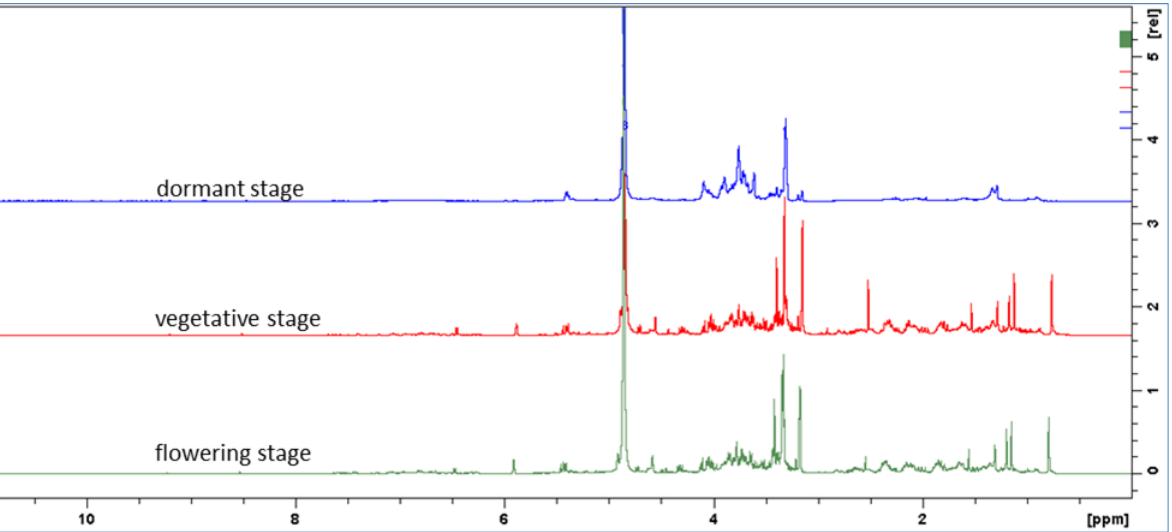
Figure 1. 1 H NMR of extracts at dormant, vegetative and flowering stages (blue, red and green) in MeOD. in